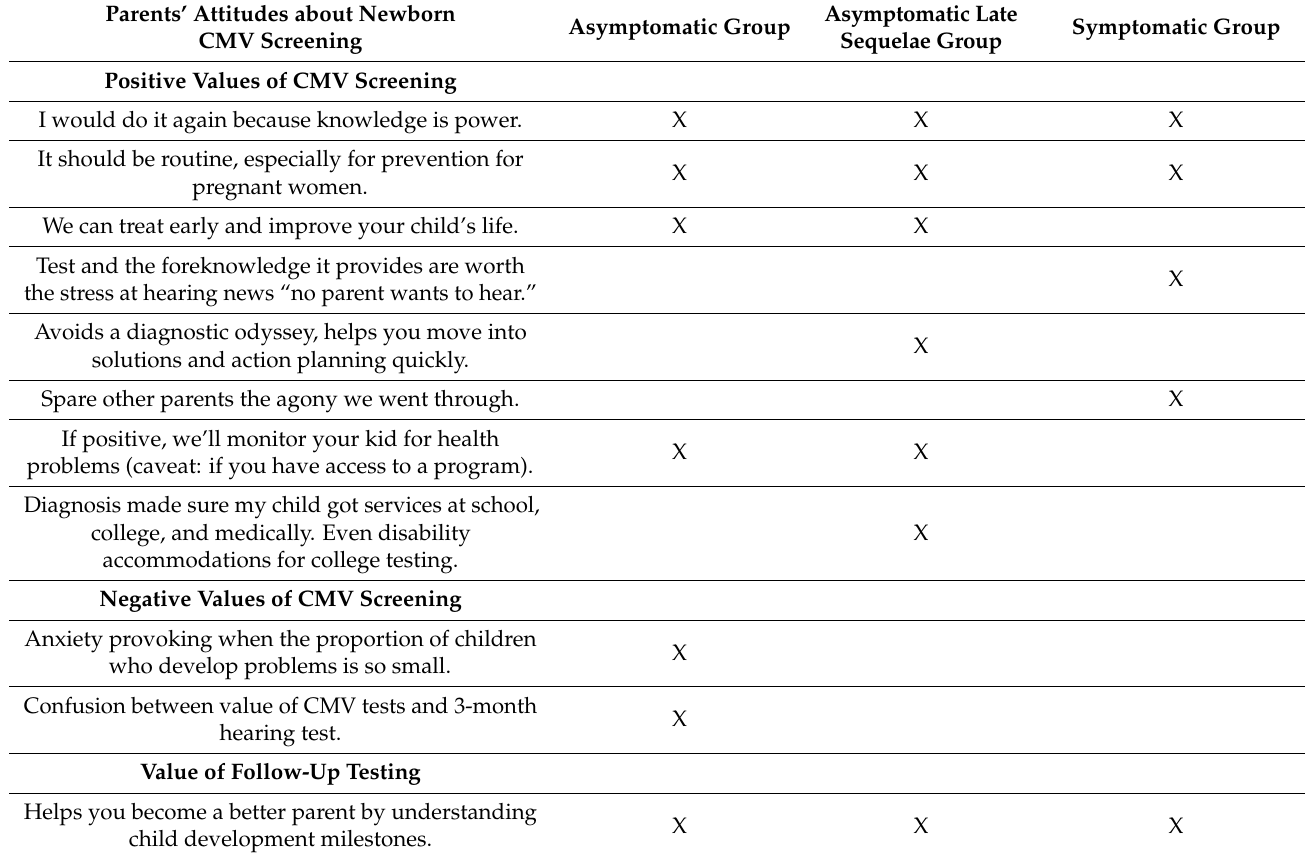
Table 2. Parents’ Attitudes about Newborn CMV